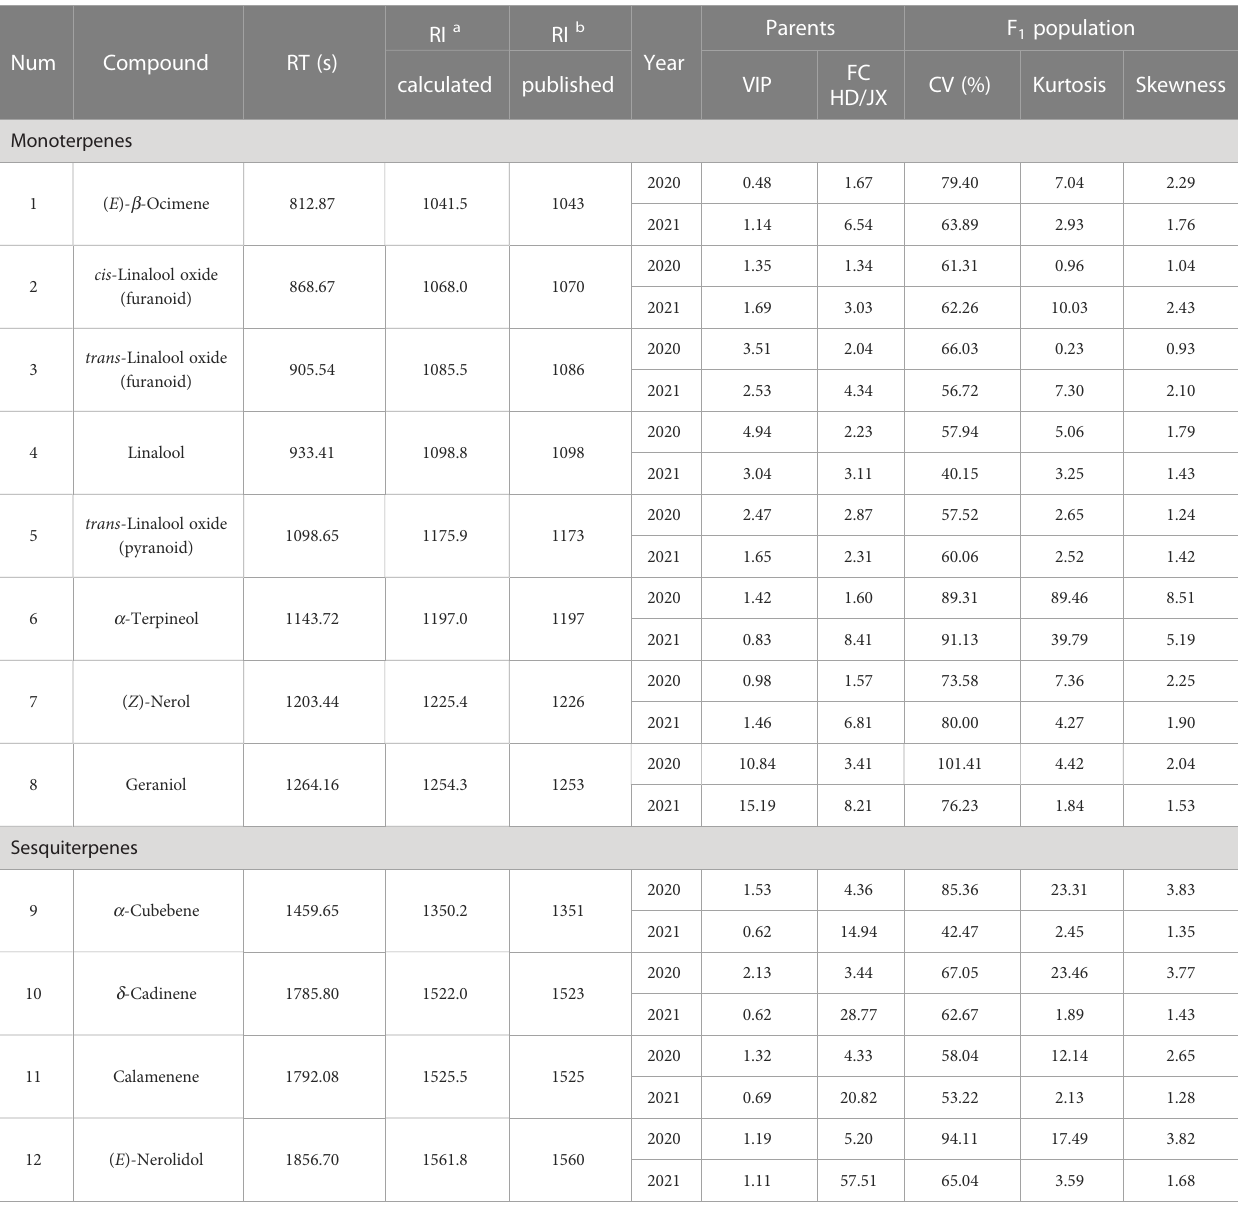
TABLE 2 Phenotypic variation of the volatile terpene contents in the ‘ HD ’ and ‘ JX ’ parents and F 1 progeny.